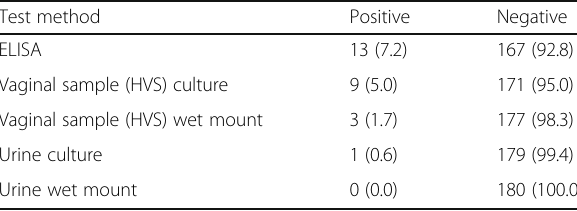
Table 2 The prevalence of T. vaginalis infection stratified by type of specimen and test methods applied